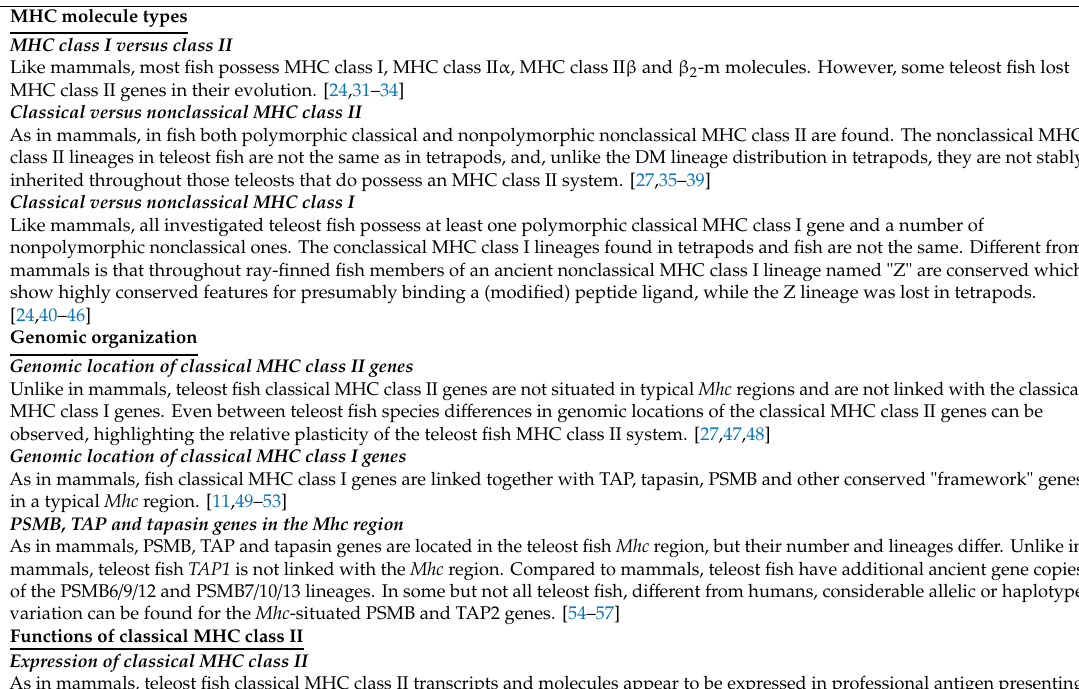
Table 1. Summary of MHC (system) traits in teleost fish compared to mammals. (important references are between